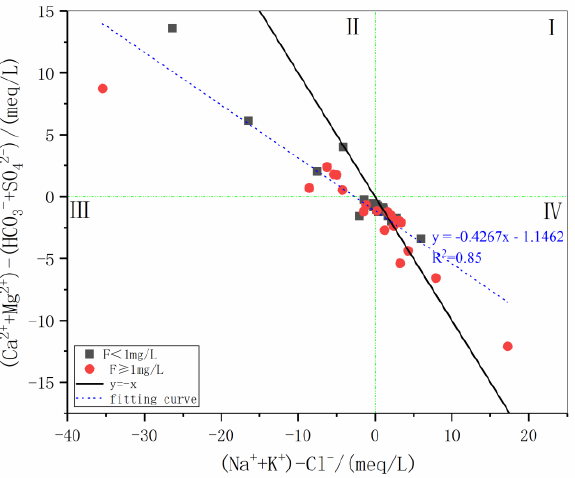
Figure 12. Amount of substance between (Ca 2+ +Mg 2+ ) − (HCO 3 − +SO 42 − ) and (Na + +K + ) − Cl −